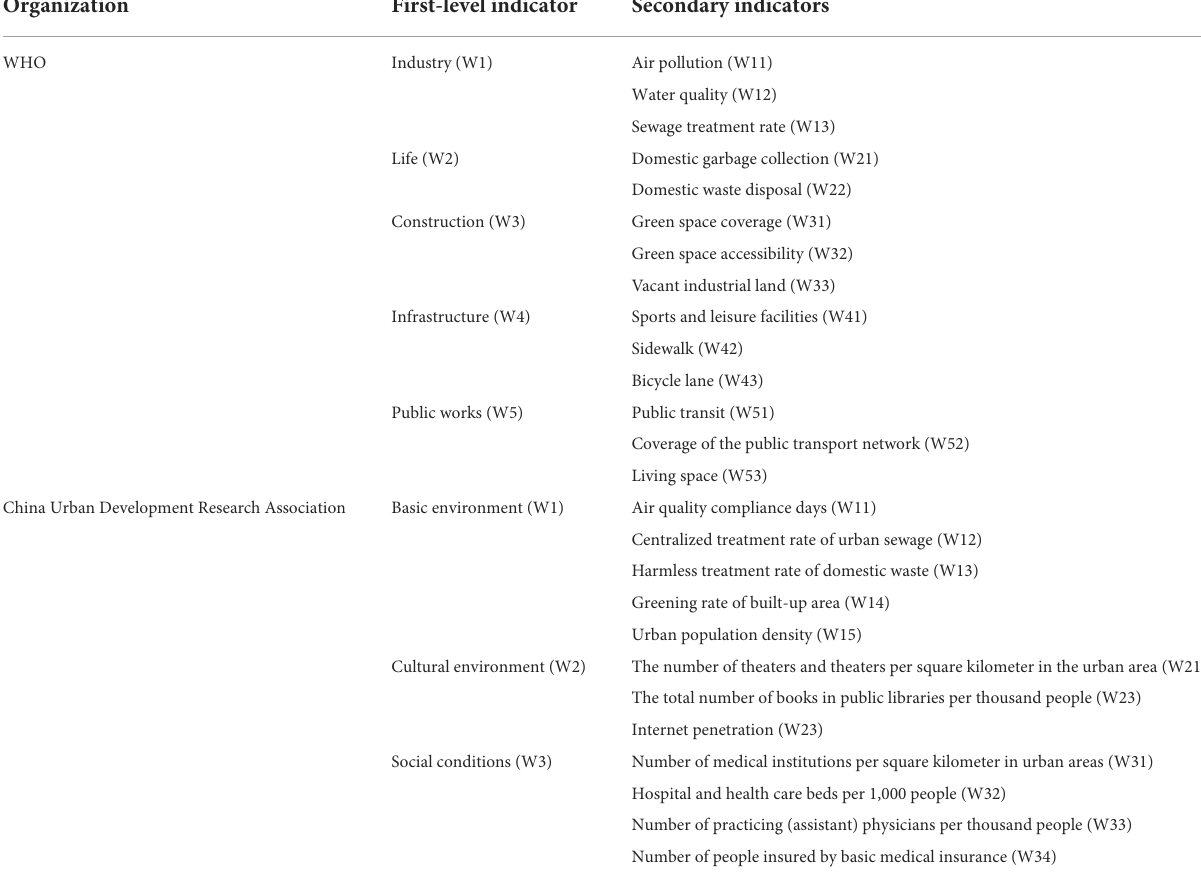
TABLE 1 The urban environmental health evaluation system of the WHO and the